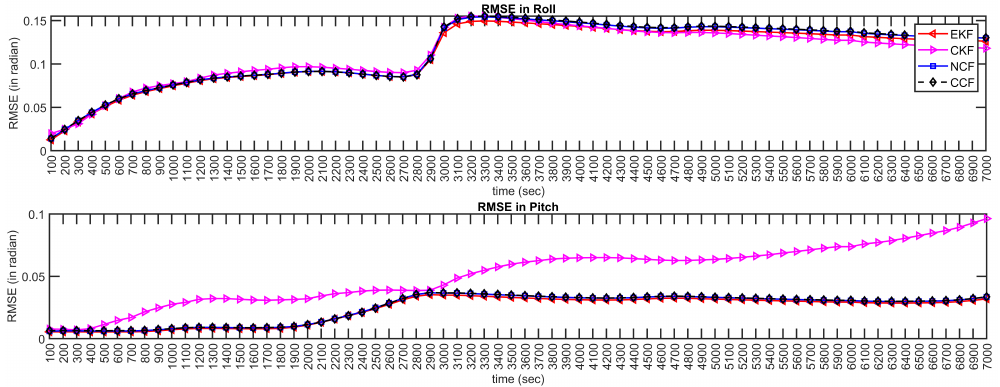
Figure 16. Estimation error over time: RMSE for every 100